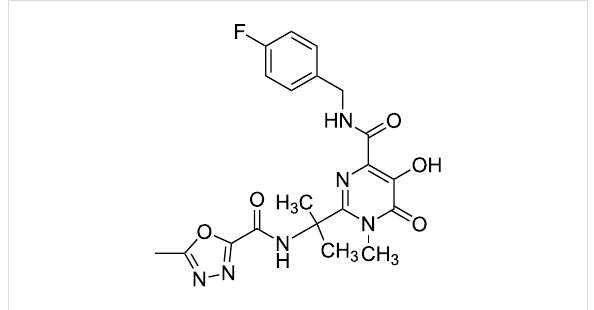
Figure 6: The molecular structure of Raltegravir. Raltegravir is an FDA approved drug used in the treatment of HIV